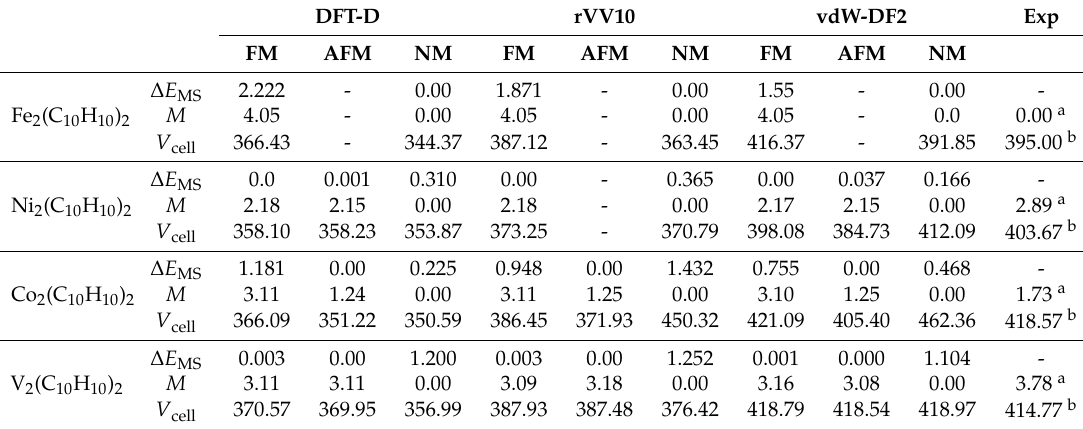
Table 1. Static properties for ordered crystalline metallocenes. Results for magnetic order (FM, AFM and NM denote ferromagnetic, antiferromagnetic and non-spin-polarized, respectively), energy difference ( ∆ E MS , eV/molecule) relative to magnetic ground state, magnetic moment ( M , µ B/molecule), and cell volume ( V cell , Å 3 ), of ferrocene, nickelocene, cobaltocene, and vanadocene, calculated using DFT-D, rVV10, and vdW-DF2 functionals. For ferrocene, a starting configuration with AFM or FM converges to the non-magnetic state for all three functionals. Therefore, the magnetic moment for the FM state is fixed to 8.0 µ B per unit cell for comparison. Note that Ni 2 C 20 H 20 with an AFM starting configuration also converges to non-magnetic with the rVV10